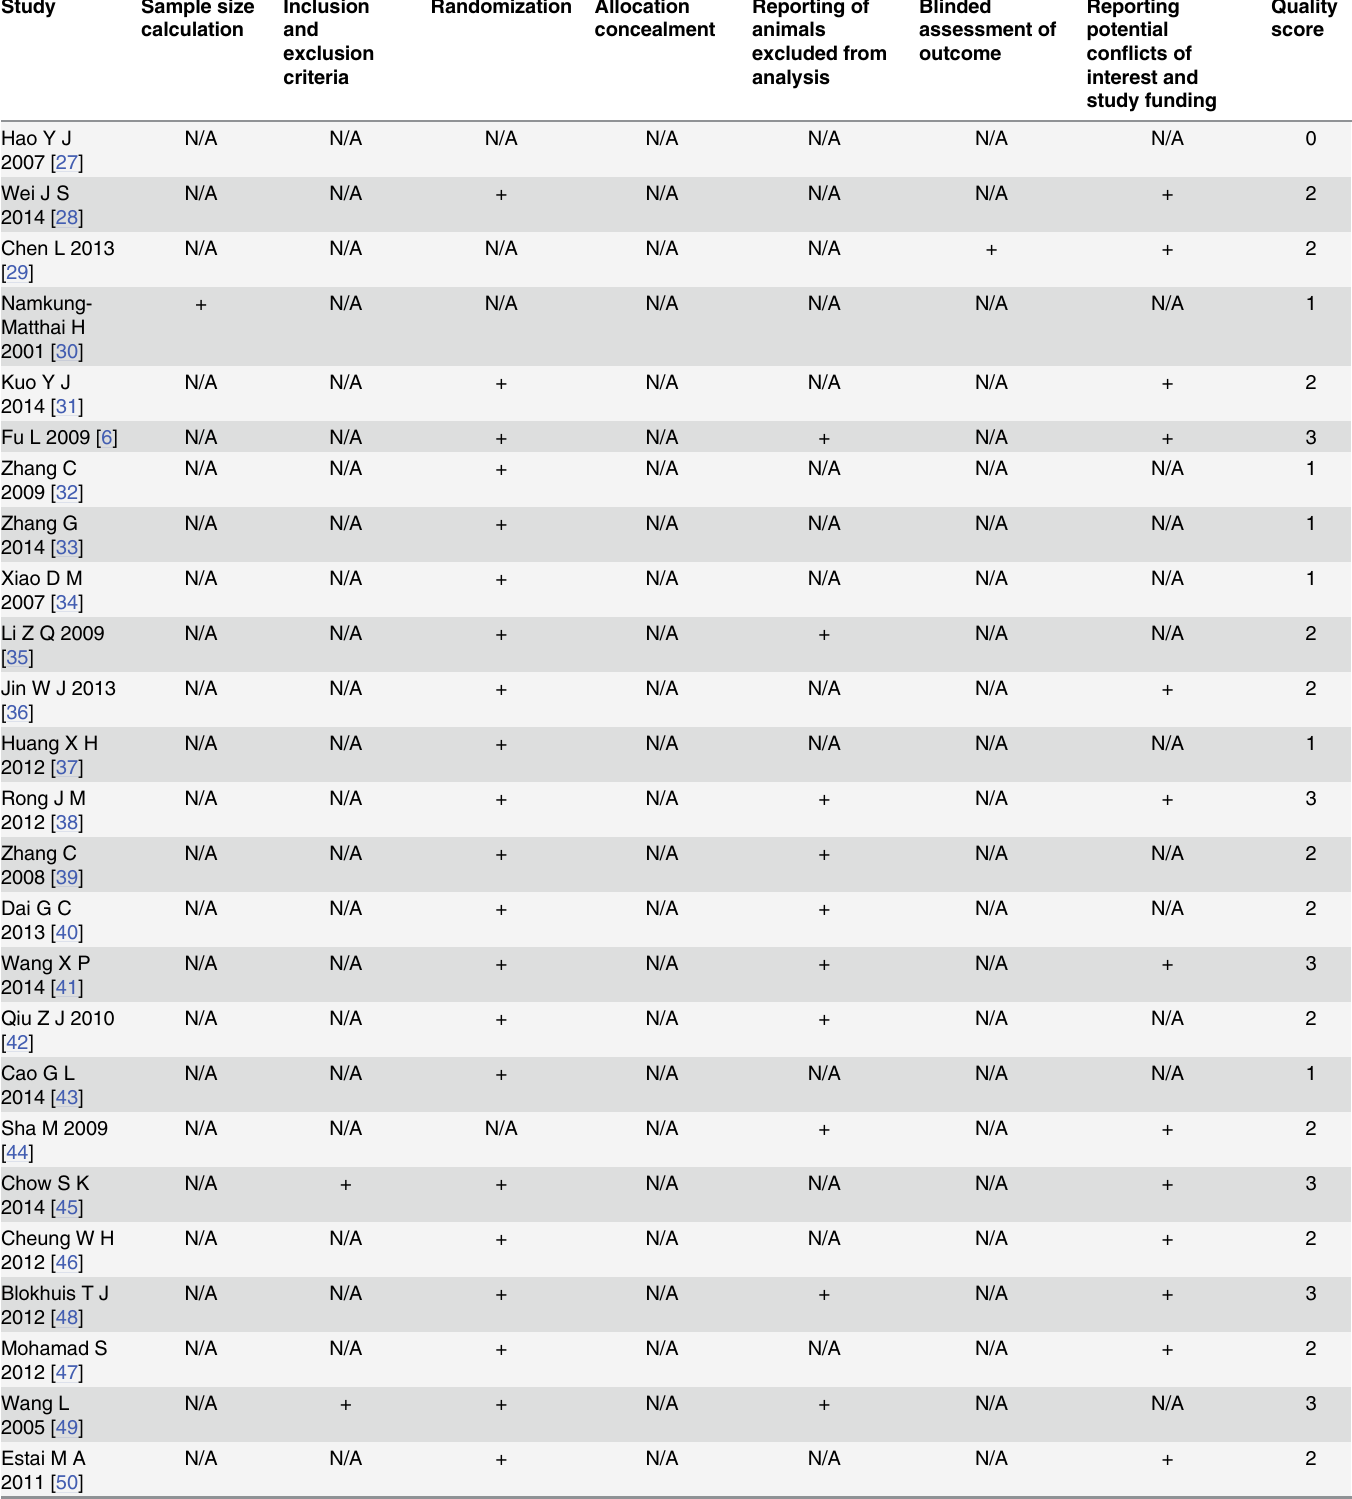
Table 2. Risk of